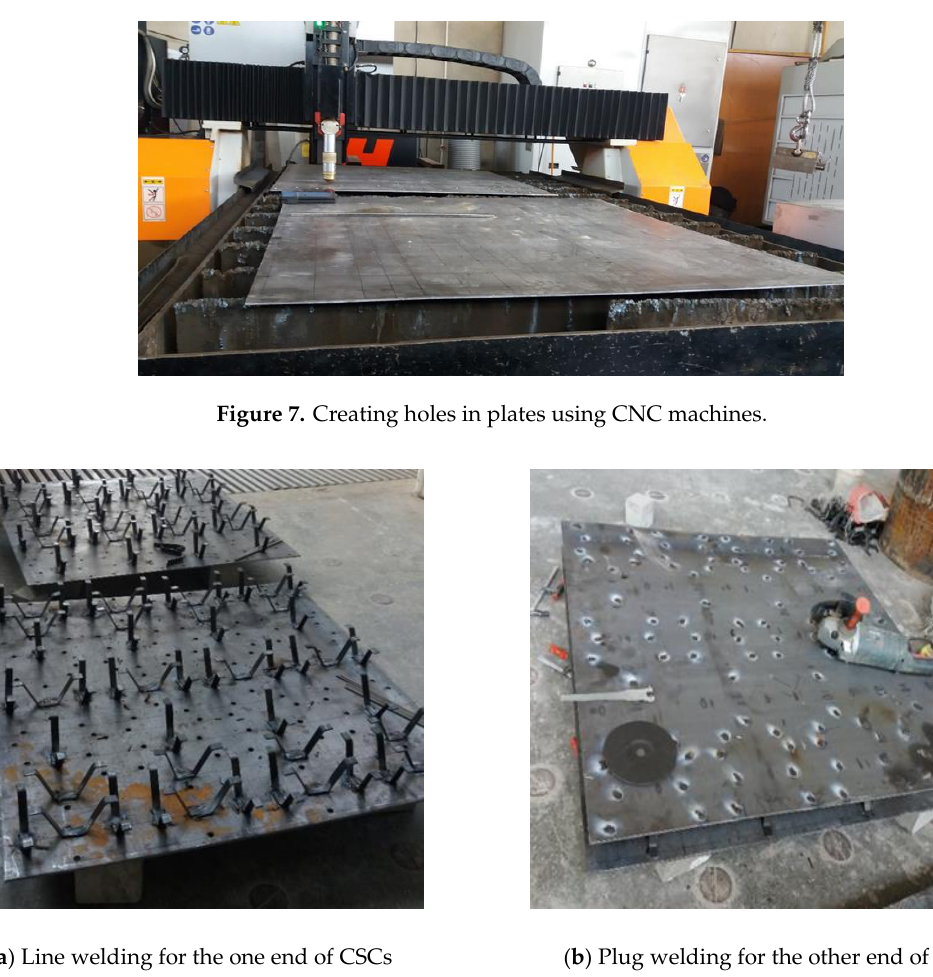
Figure 8. The CSC connectors welding on the steel face plates.